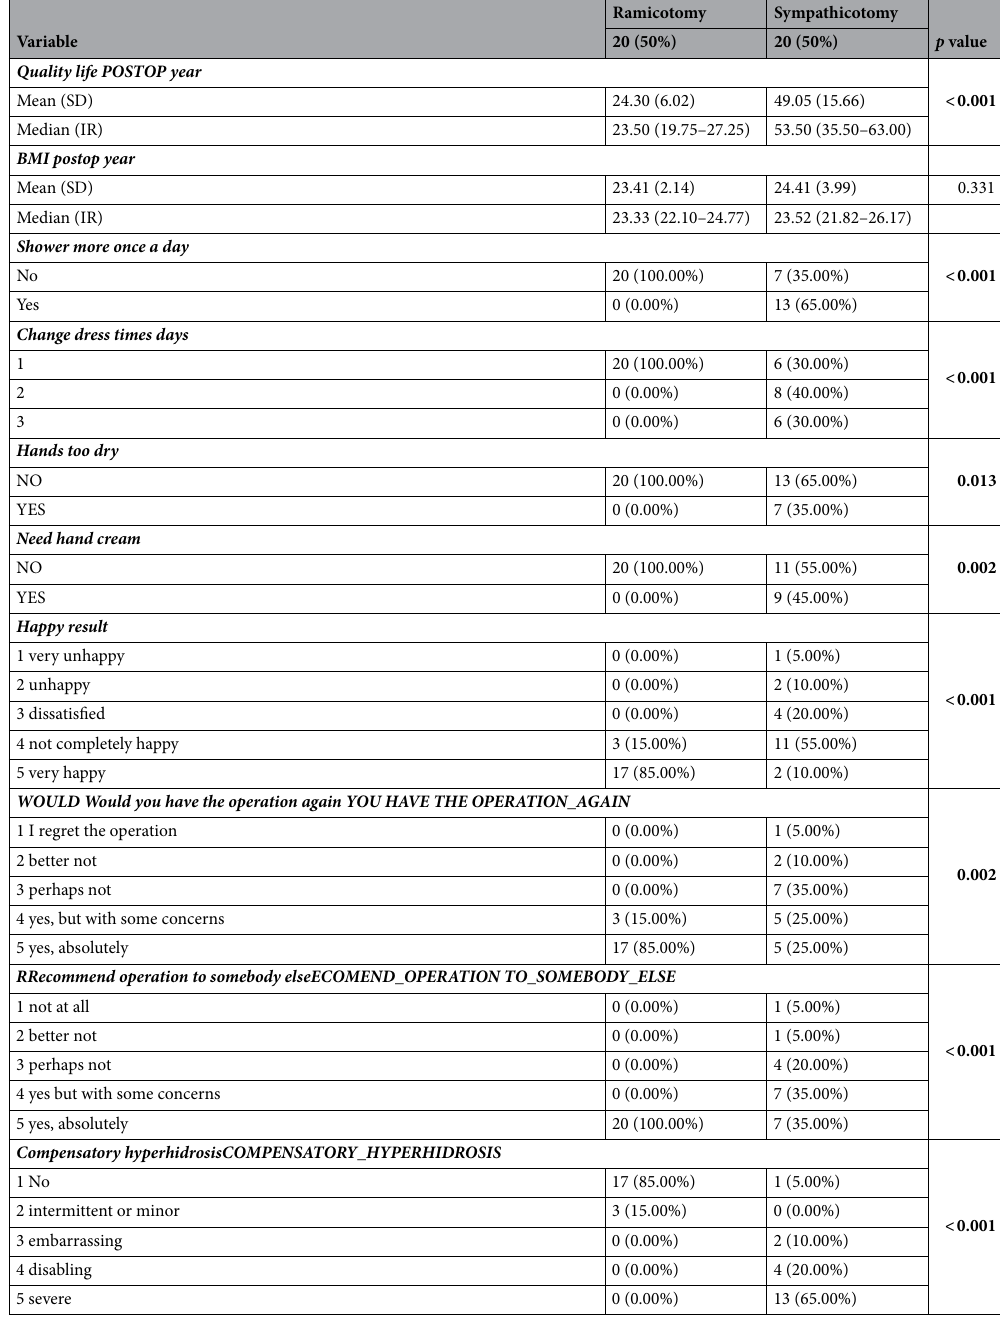
Table 3. Postoperative quality of life and sweating changes in different anatomical areas during July. Patients undergoing SY reported worse results than RC ones. The higher figure in the quality of life scale means that there was minor improvement postoperatively. Analyzing the BMI (body mass index at the time of follow-up in July), we found no statistically significant differences between the groups. The CH and its consequences were milder in the gray rami communicantes RY than in the SY group. significance is for p